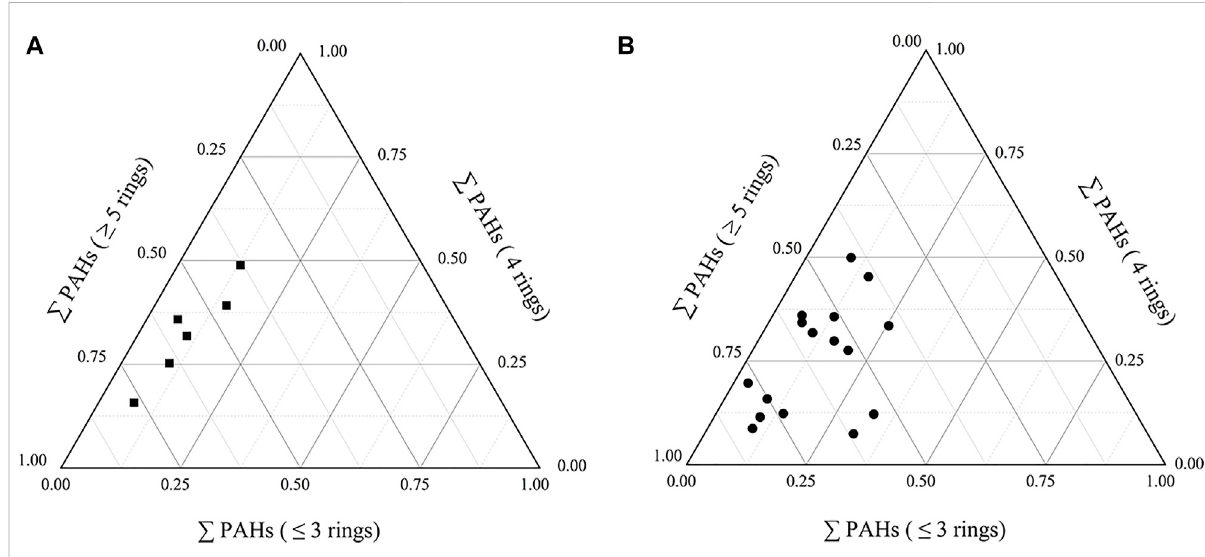
FIGURE 3 Ternary phase diagram of different ring numbers in different years (A) and seasons (B) from 2018 to